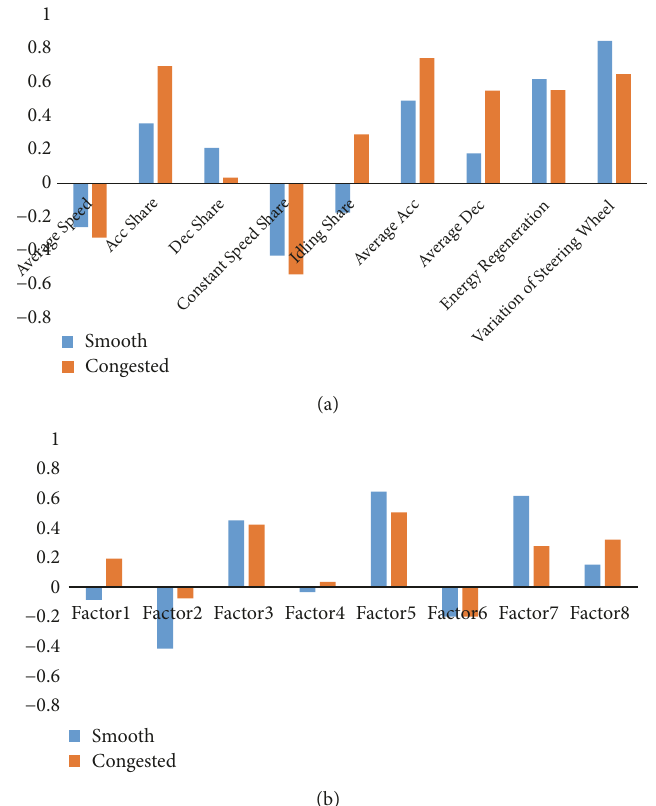
Figure 6: Correlations between journey energy consumption and DSQ (a), and measured driving behaviors (b).